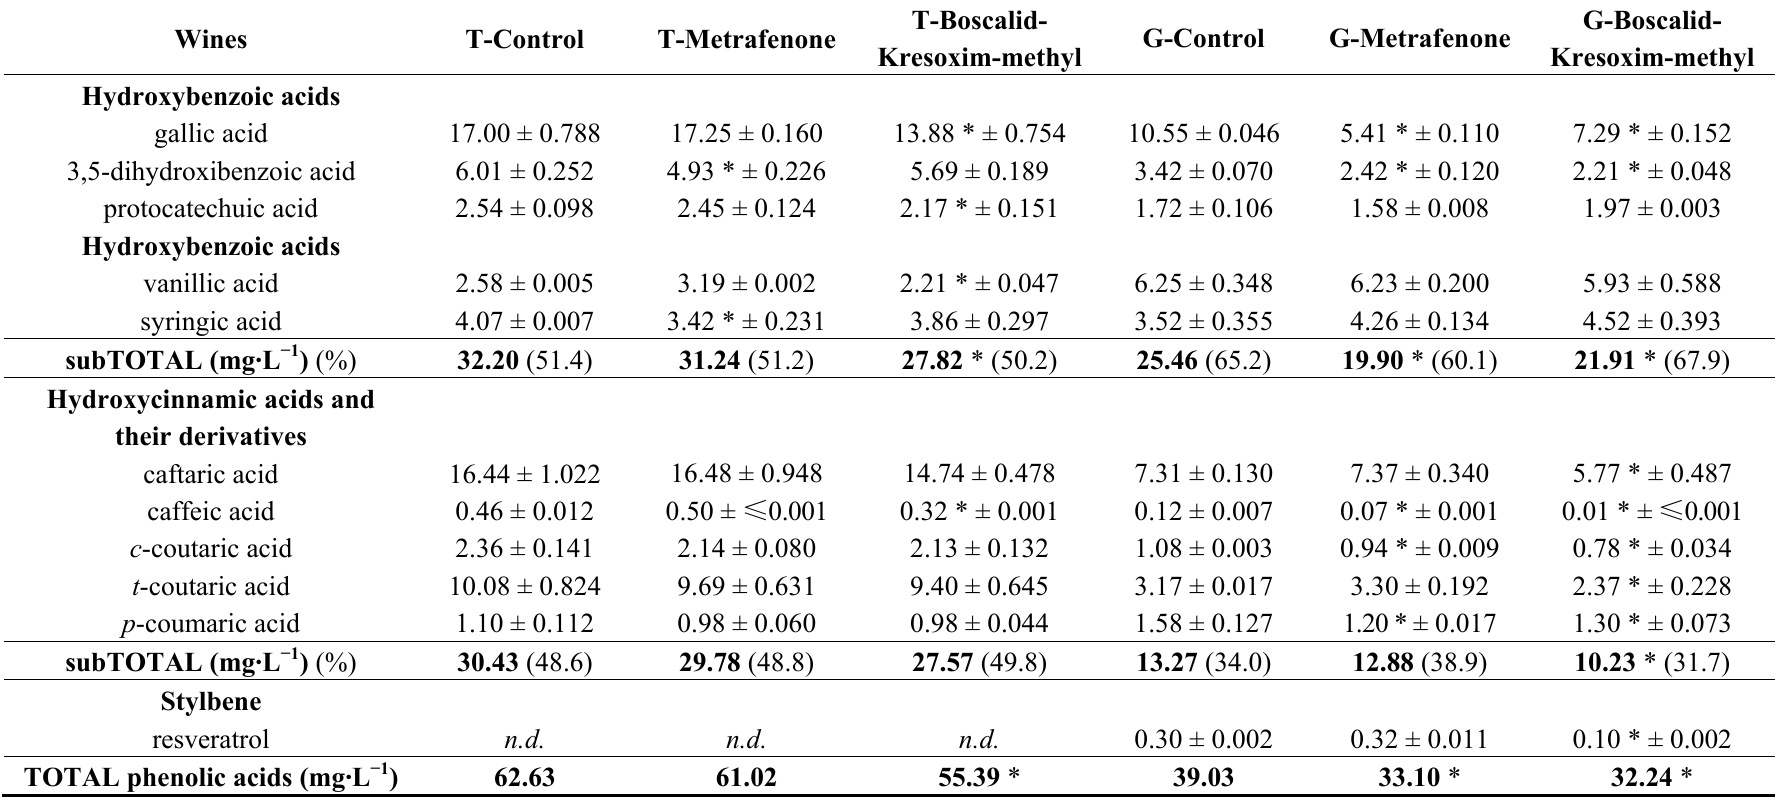
Table 4. Phenolic acid composition and quantitative data (mg·L − 1 ± SD) in Tempranillo and Graciano